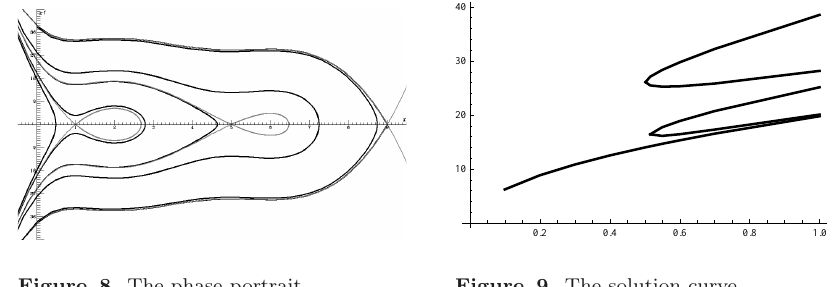
Figure 8. The phase portrait. Figure 9. The solution